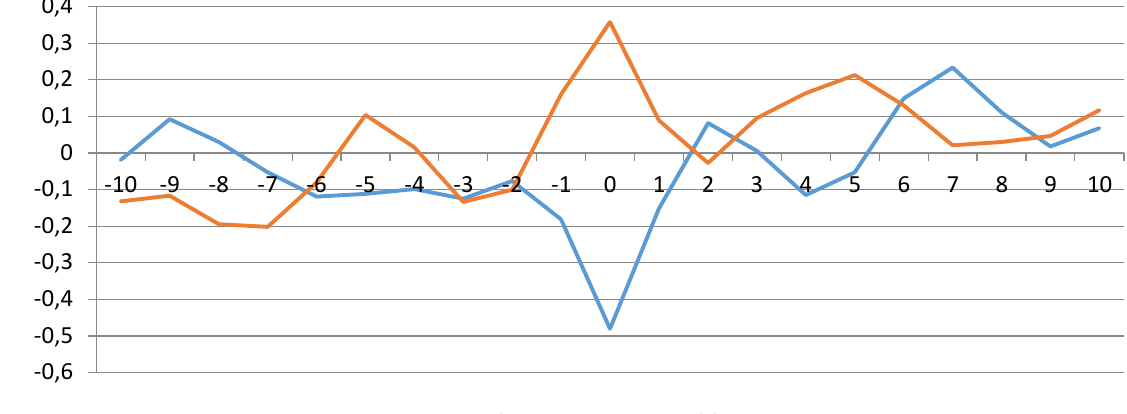
Figure 9. The cross-correlation between PFTS index log returns and frequency of overreactions over the total sample period for different lead and lag intervals